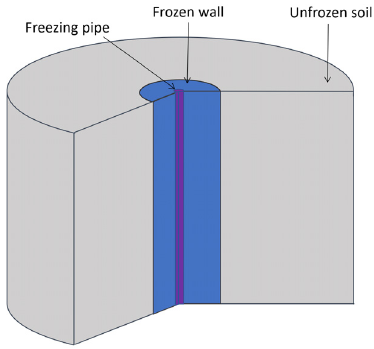
Figure 2. Considered computational domain.